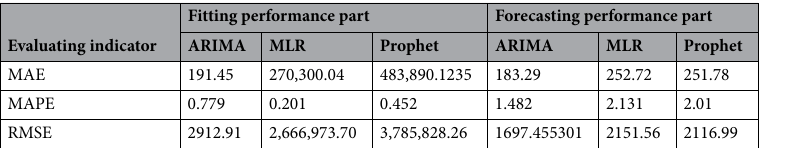
Table 5. The Comparison of MAE, MAPE, and RMSE values of three